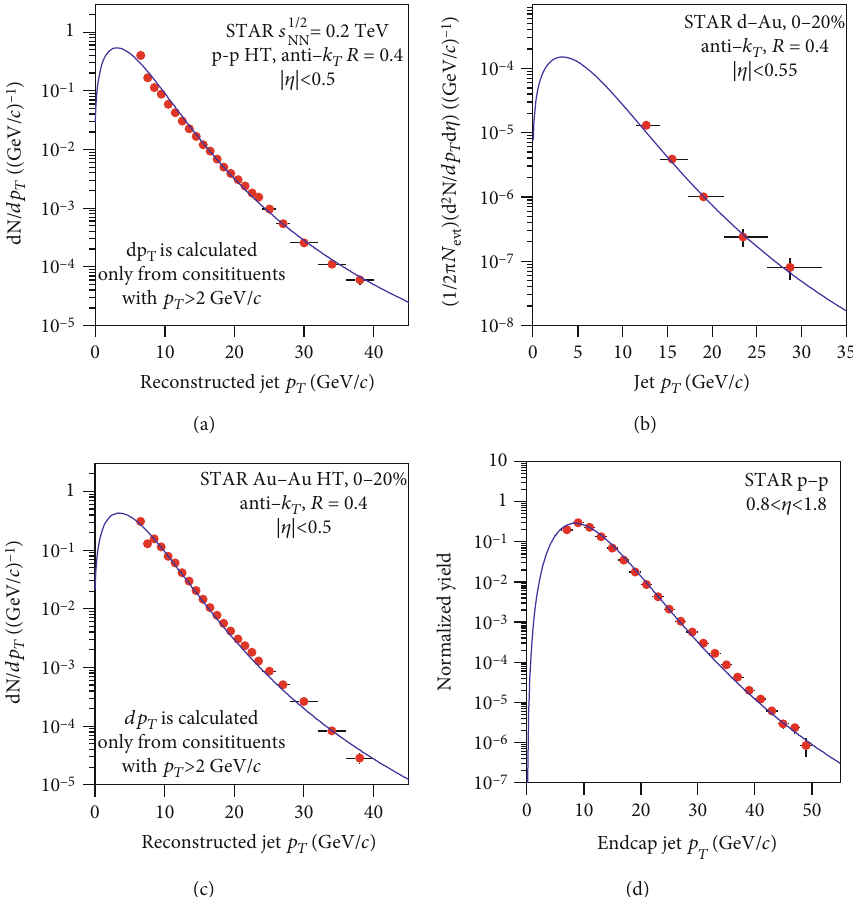
ffiffiffiffiffiffiffi p s = 0 : 2 TeV . The symbols are cited from the experimental data NN